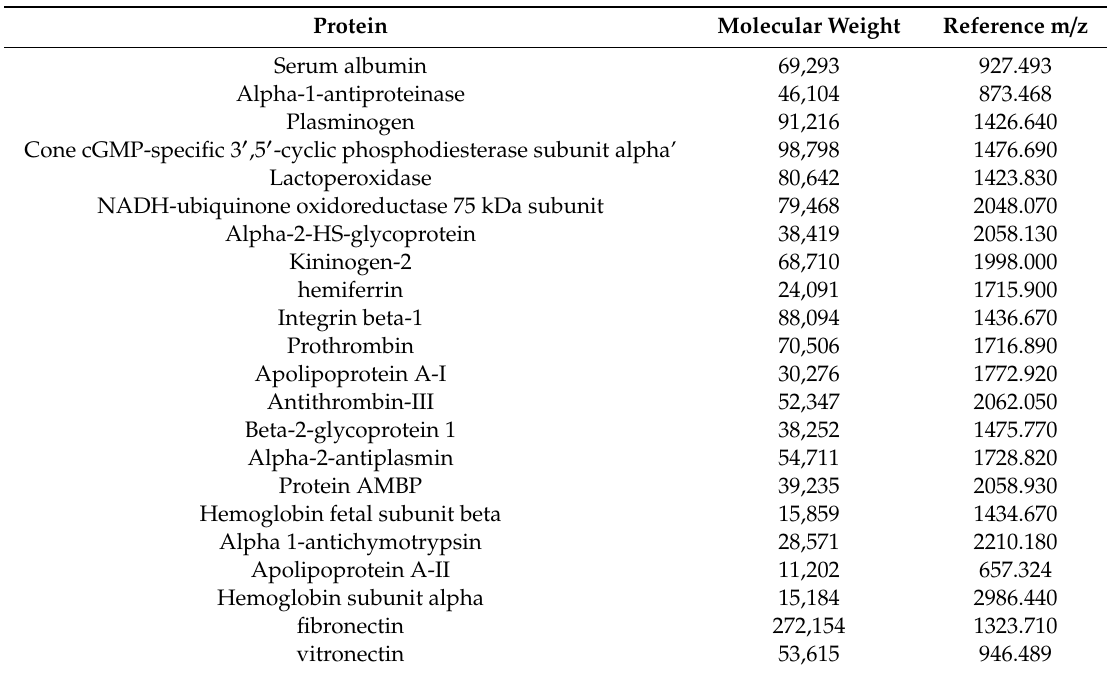
Table 2. Proteins of interest in serum (abundant and those with RGD moieties), their molecular weights, and reference m / z obtained by the procedure presented in Figure